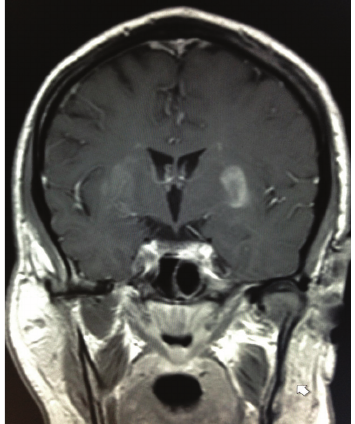
Figure 2: Axial DWI does not show evidence of restricted diffusion.